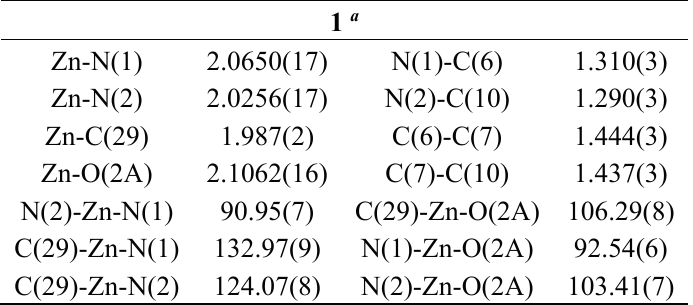
Figure 2. Molecular structure of 1 (hydrogen atoms omitted for clarity). Table 1. Selected bond lengths (Å) and bond angles (°) for 1 and 7